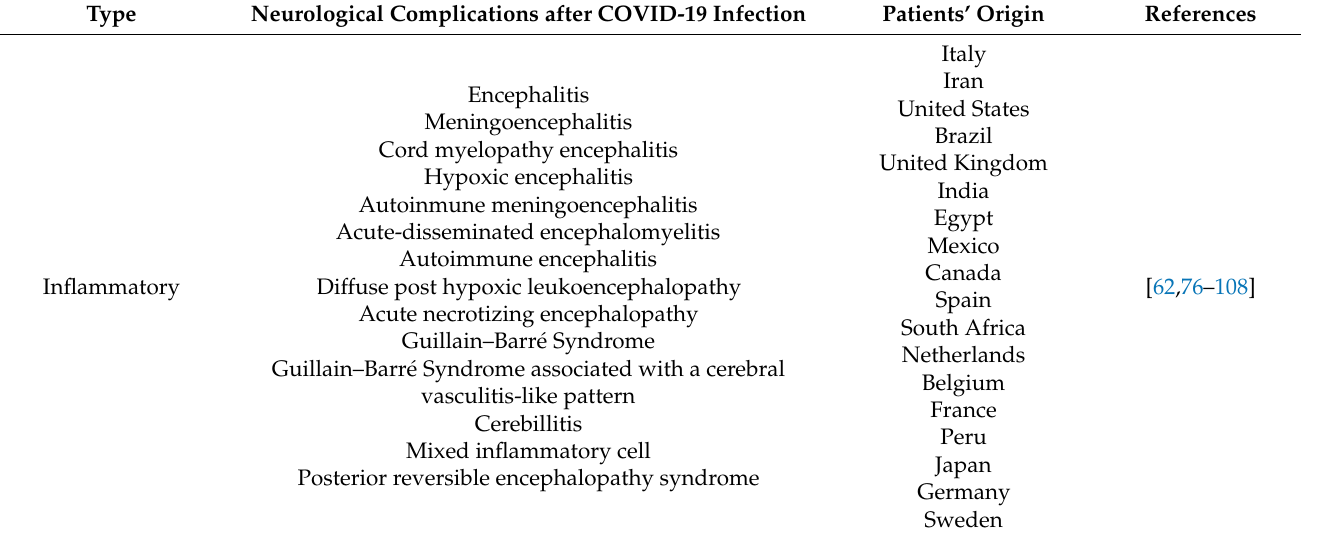
Table 1. Neurological manifestations in patients infected with